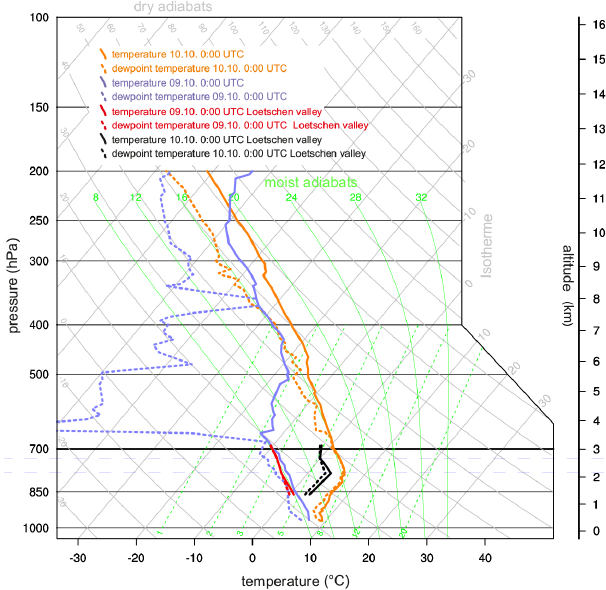
Figure 3. Skew-t–log-P diagram showing the vertical atmospheric structure as measured from weather balloons launched at Payerne (cf. Fig. 1) on 9 October 2011 00:00UTC (blue lines) and 10 Oc- tober 2011 00:00UTC (orange lines). The profile of the Lötschen Valley as retrieved by surface meteorological stations is included for comparison (red for 9 October 00:00UTC and black for 10 Octo- ber 00:00UTC). The main ridge of the Lötschen Valley has a mean elevation of approximately 3000ma . s . l . (thick horizontal